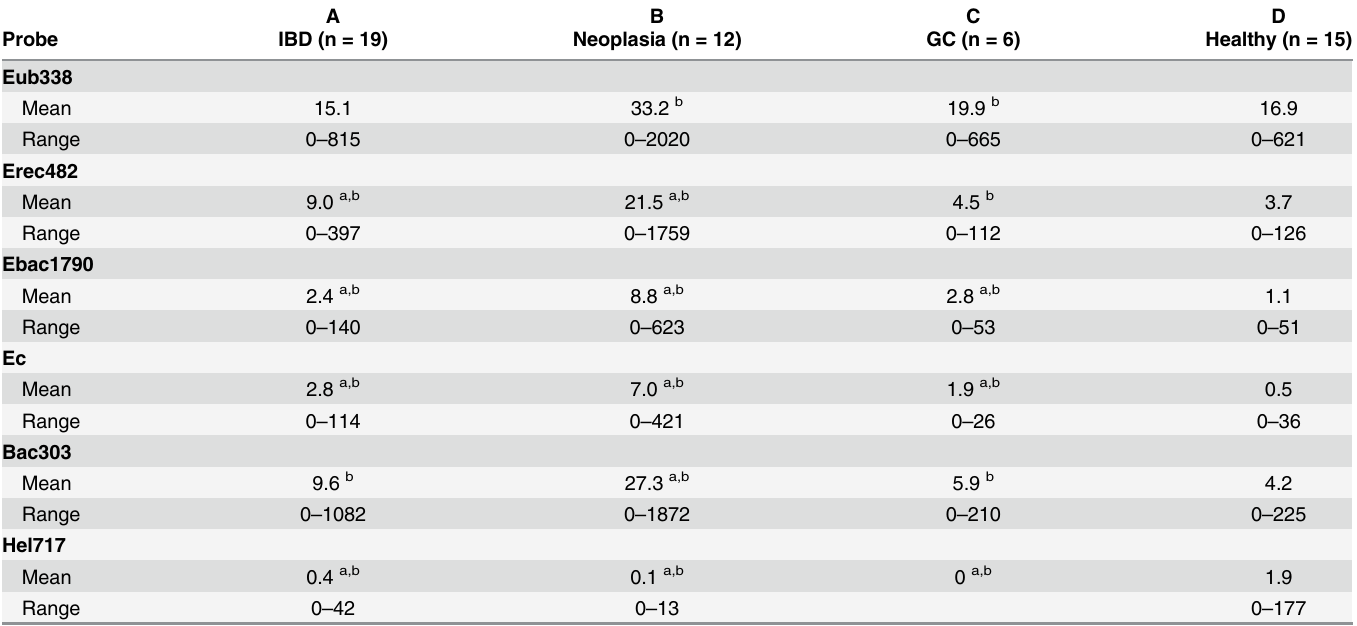
Table 5. Number of colonic bacteria in healthy and diseased